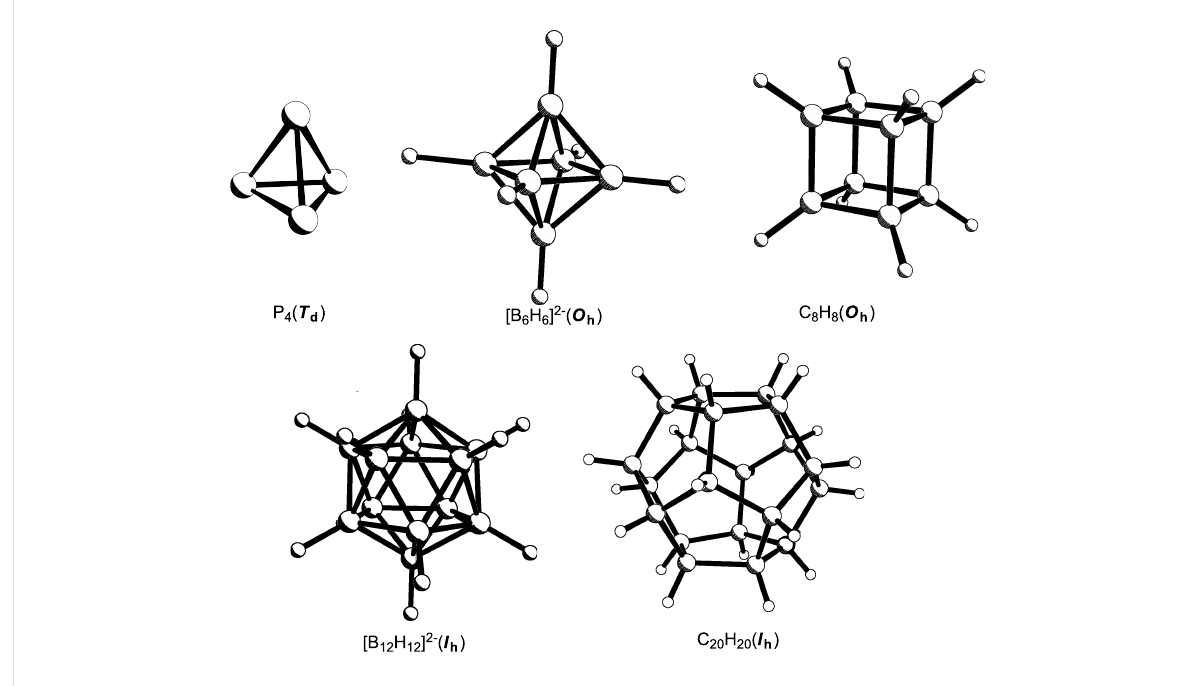
Figure 1: Molecular analogues of the Platonic solids.